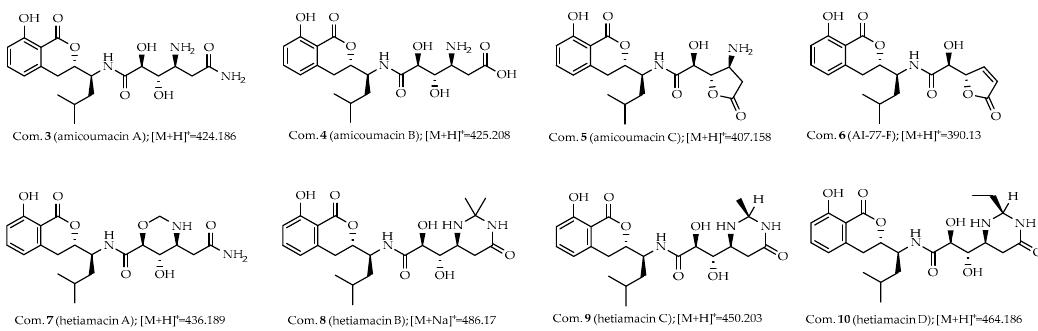
Figure 3. Known amicoumacins identified by using MS/MS-based molecular networking. Analog search and reference compound annotations with the previously identified amicoumacins ( 3 − 10 ) from strain PJS, and the corresponding spectral nodes were indicated with the numbers.